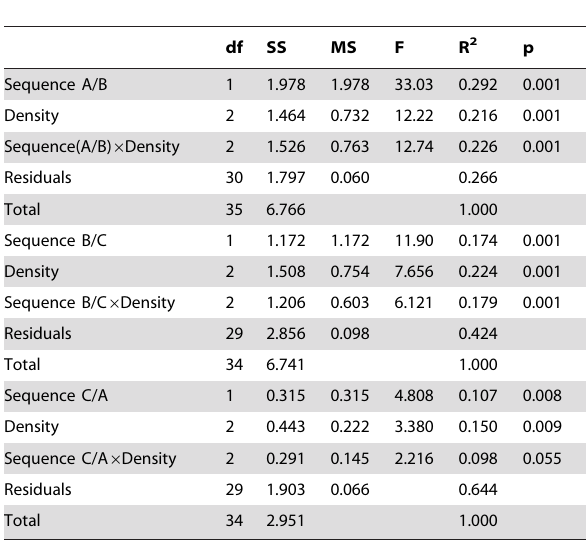
Table 4. Pairwise a posteriori tests for (a) first arrival 6 density and (b) late arrival 6 density by PERMANOVA with Bray-Curtis distances in the protozoan community states.